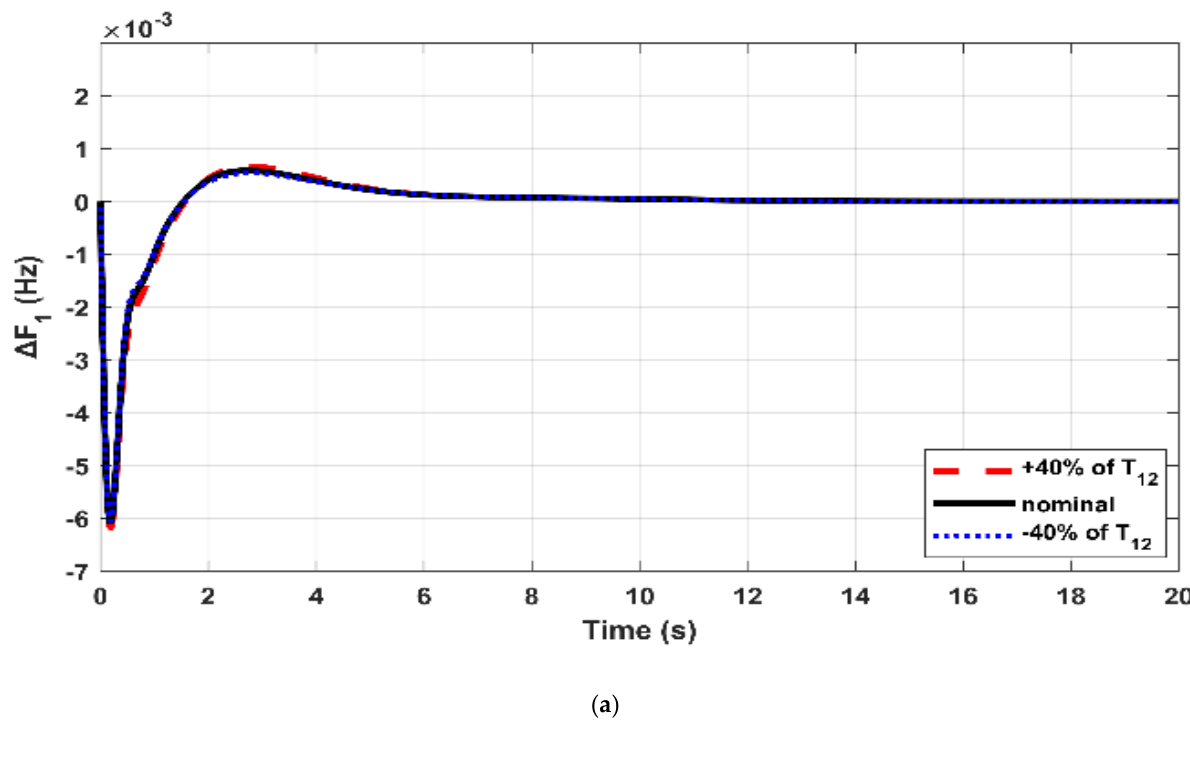
Figure 11. Bar graph of percentage improvement considering case 2.